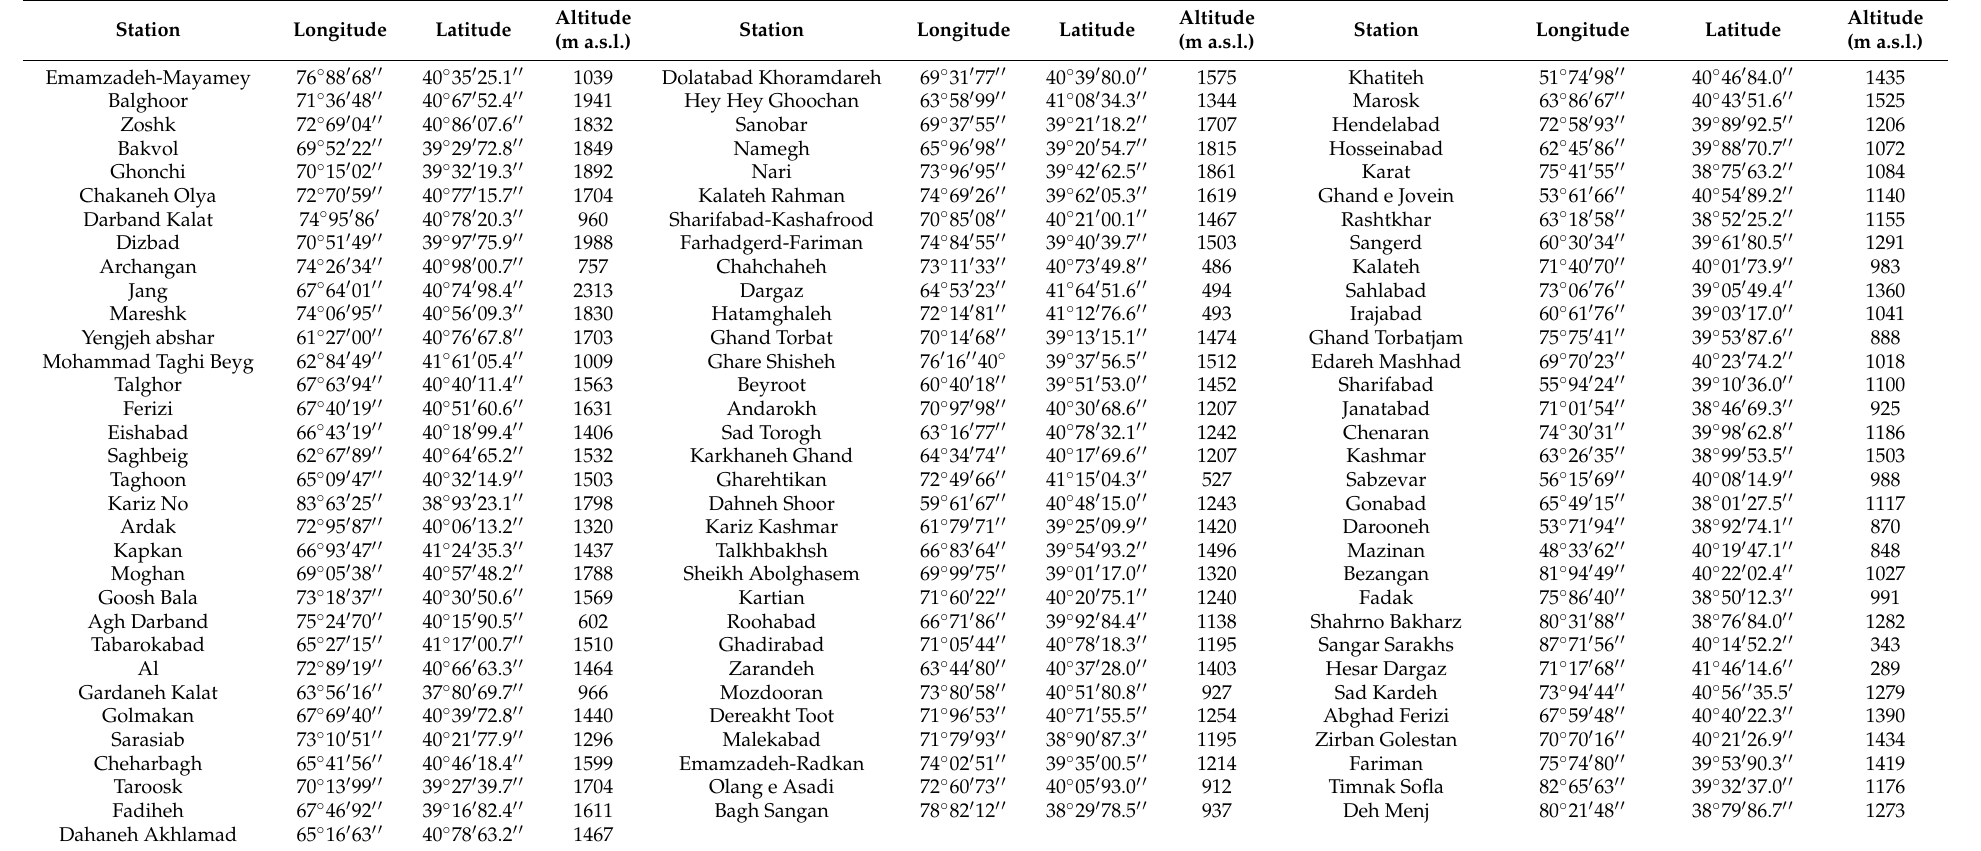
Table 1. Locations and altitudes of the meteorological stations used for this